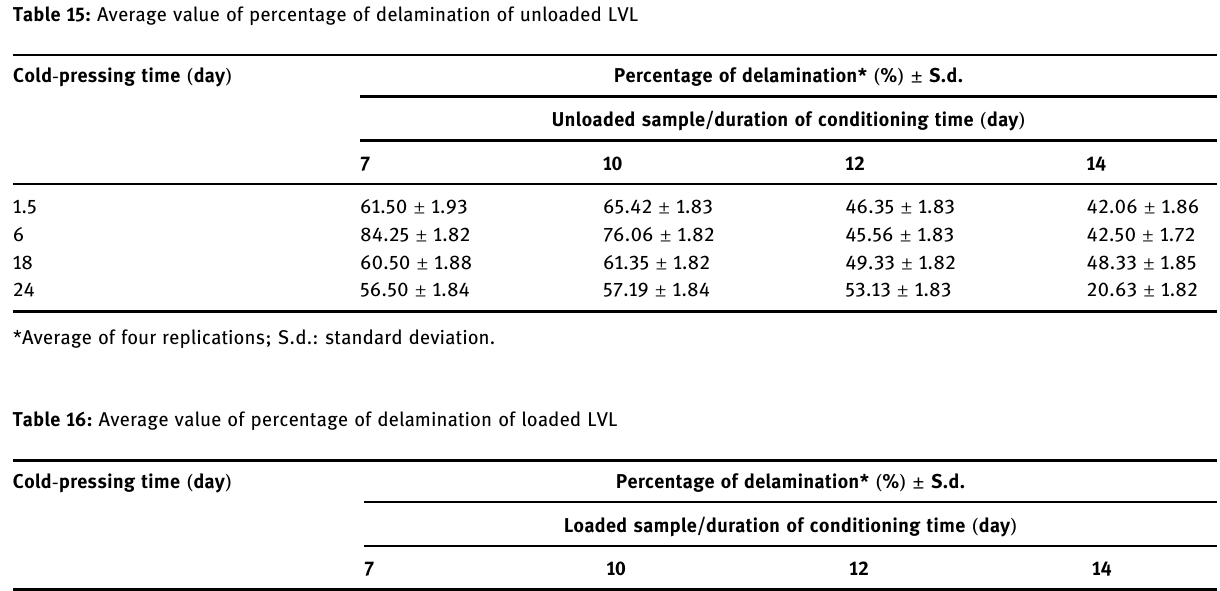
Table 15: Average value of percentage of delamination of unloaded LVL